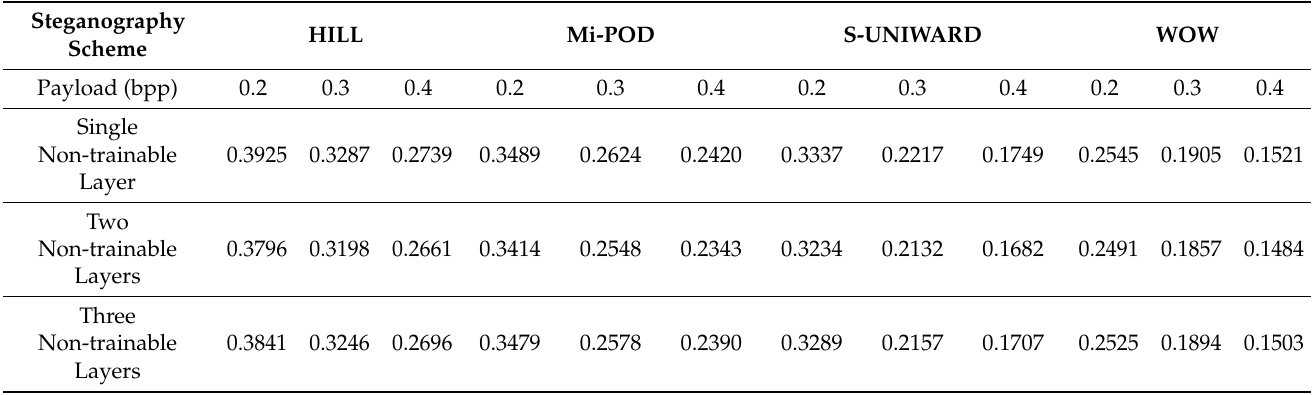
Table 2. Detection errors using different non-trainable convolutional layers.